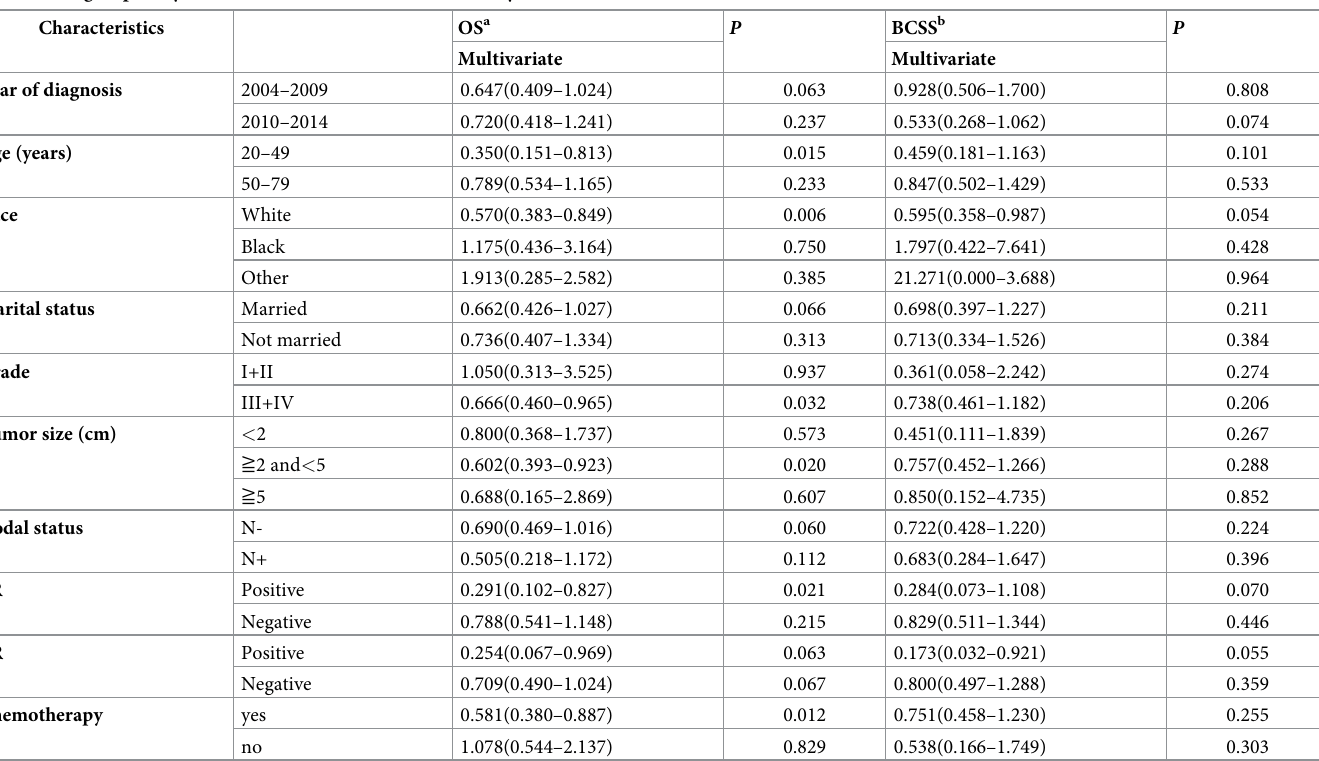
Table 3. Subgroup analysis of OS and BCSS in multivariate analysis.